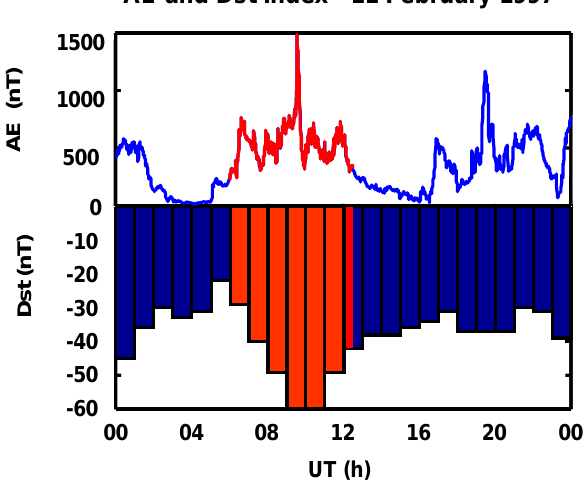
Fig. 9. Hourly D st and the 1min AE indices for 11 February 1997. The periods in red denote the times of observation at EISCAT. The whole period was relatively active but a minimum in the D st index occurs around 09:00 to 11:00UT. AE shows an initial sharp in- crease close to 05:00UT before a much larger step after